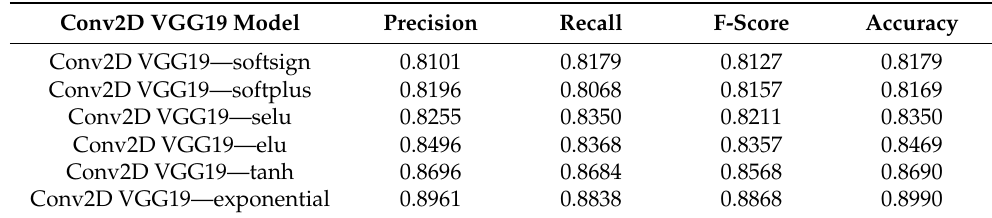
Table 5. Performance analysis for Conv2D VGG19 model with various activation layers.